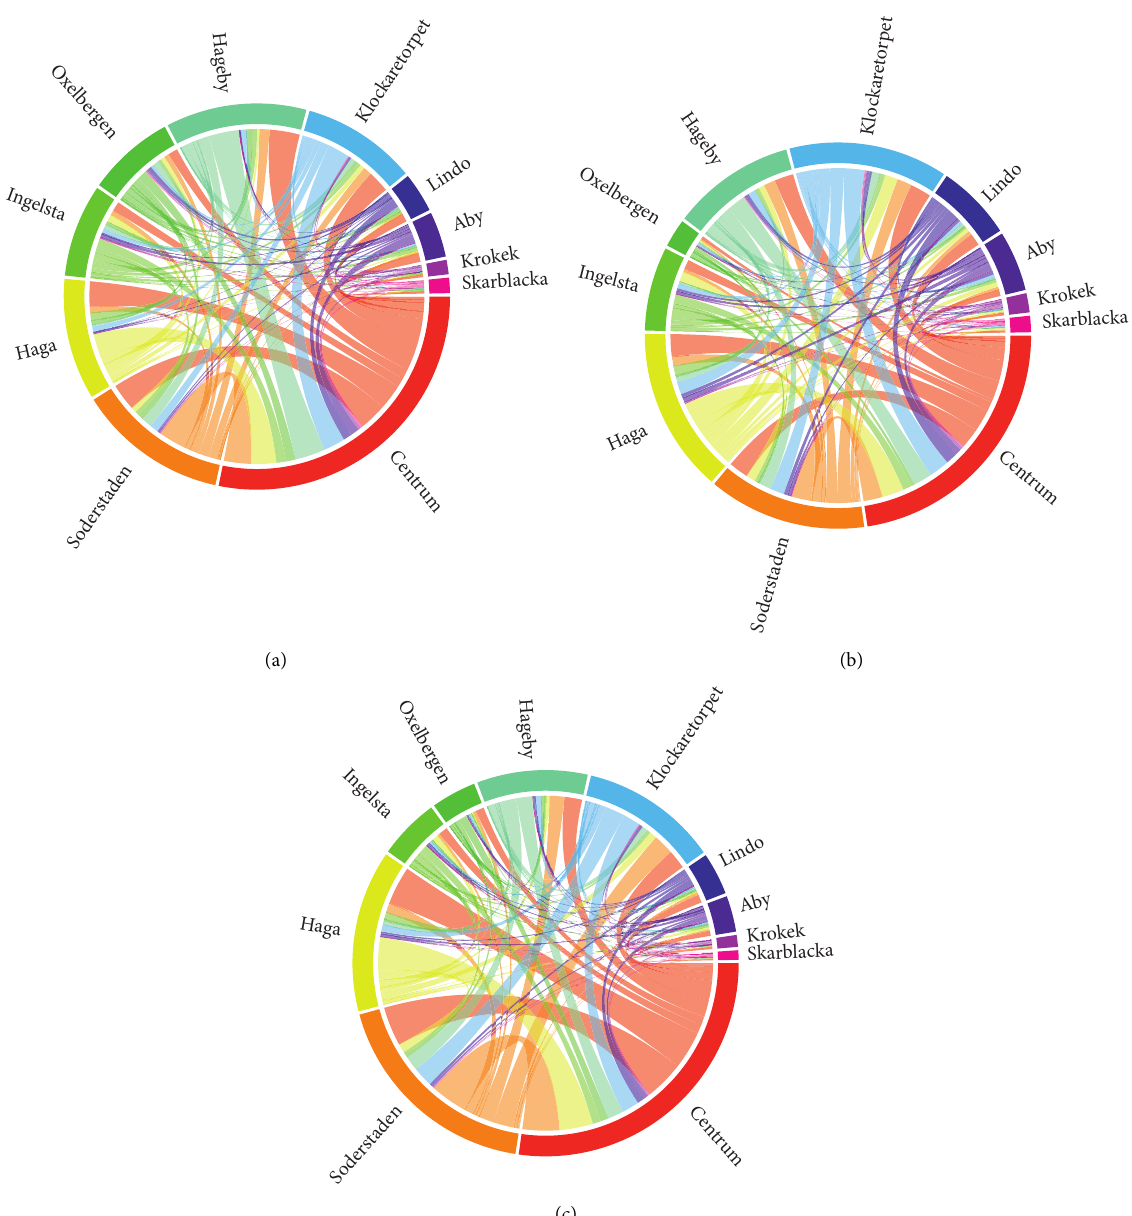
Figure 10: The OD flows inferred from cellular network data using the STOP (top left), MOVEMENT (top right) algorithms, and the municipality’s travel demand model (bottom). For readability, only 11 zones (with all densely populated areas) out of the 24 are displayed. The width of the connectors corresponds to the flow in each OD